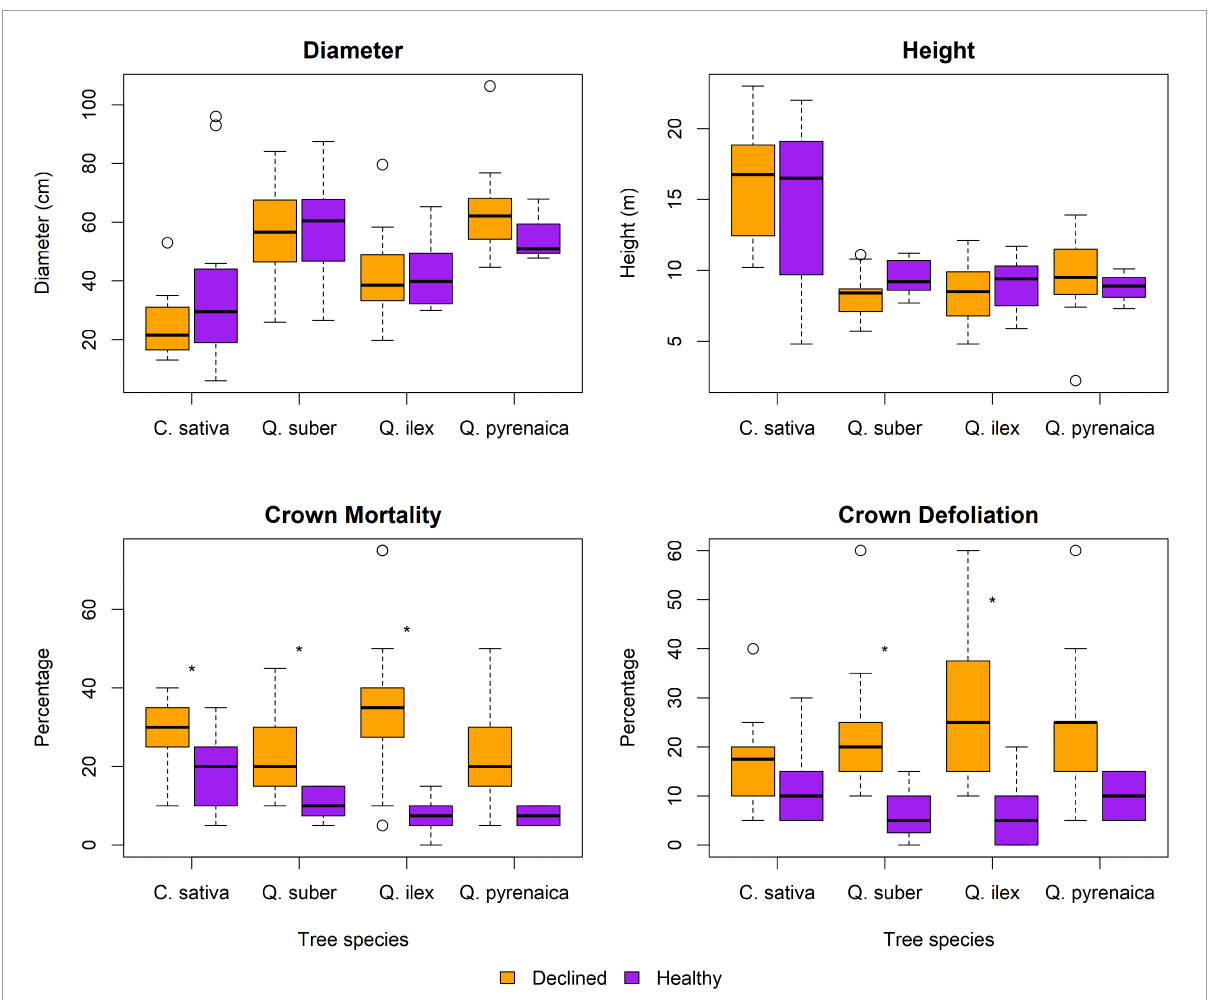
FIGURE2 Dendrometric measurements. Boxplots correspond to 15 symptomatic and 15 asymptomatic individuals per tree species, later on pooled into 3 replicates of n = 5 (per health status) for metabarcoding analysis. Asterisks mark statistically significant differences (Wilcoxon tests, p < 0.05 after Bonferroni